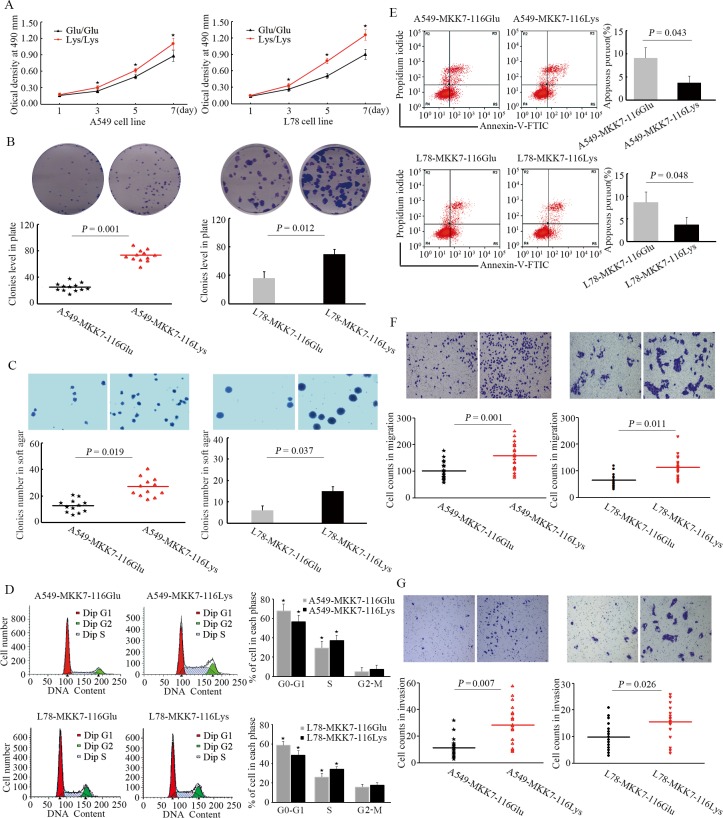
Effects of MKK7 p.Glu116Lys on cellular proliferation, apoptosis, migration, and invasion.(A). A549 and L78 cells were seeded into 96-well plates after transfected with MKK7-116Glu or MKK7-116Lys lentivirus, and cell proliferation was evaluated every other day for a week using the MTT assay. OD values from four independent experiments were assessed (* indicated that a statistical significance with P < 0.05 between the groups). (B). Representative colony formation assay in 6-well plates both for A549 and L78 cells. The comparison of different colonies level between MKK7-116Glu-cells and MKK7-116Lys-cells was assessed by student’s t-test. (C). In soft agar assay, colonies number in cells with over-expressing MKK7-116Lys were much higher than cells transfected with MKK7-116Glu. Colonies were stained with crystal violet, and were counted in four randomly selected points in each well under the microscopy (original magnification: ×100). (D). Cell cycle analysis of A549 and L78 cells after transfection with lentiviruses containing different p.Glu116Lys allele. (E). Annexin V-FITC/PI apoptosis assay of A549 and L78 cells after transfection with MKK7-116Glu or MKK7-116Lys lentivirus. (F, G). Cell migration and invasion assays were performed. The upper chambers were seeded with various cell lines. The membranes of the chambers were stained with crystal violet. All data were representative of at least three separate experiments.